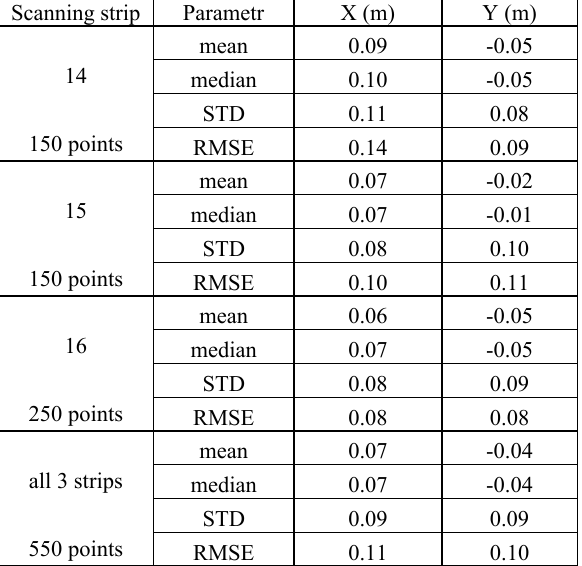
Table 2. The result of measurements of points on LIDAR intensity image.